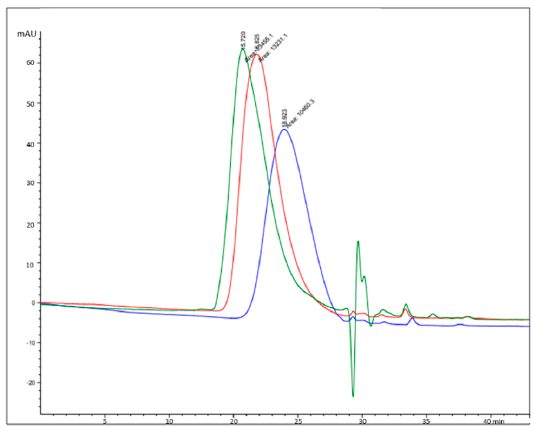
Figure 8. Overlay of the chromatograms of sample HA-Na 13 kDa (blue), Ha-Na 50 kDa (red), and T15F1 (green). In the horizontal axis the retention times in minutes are reported.